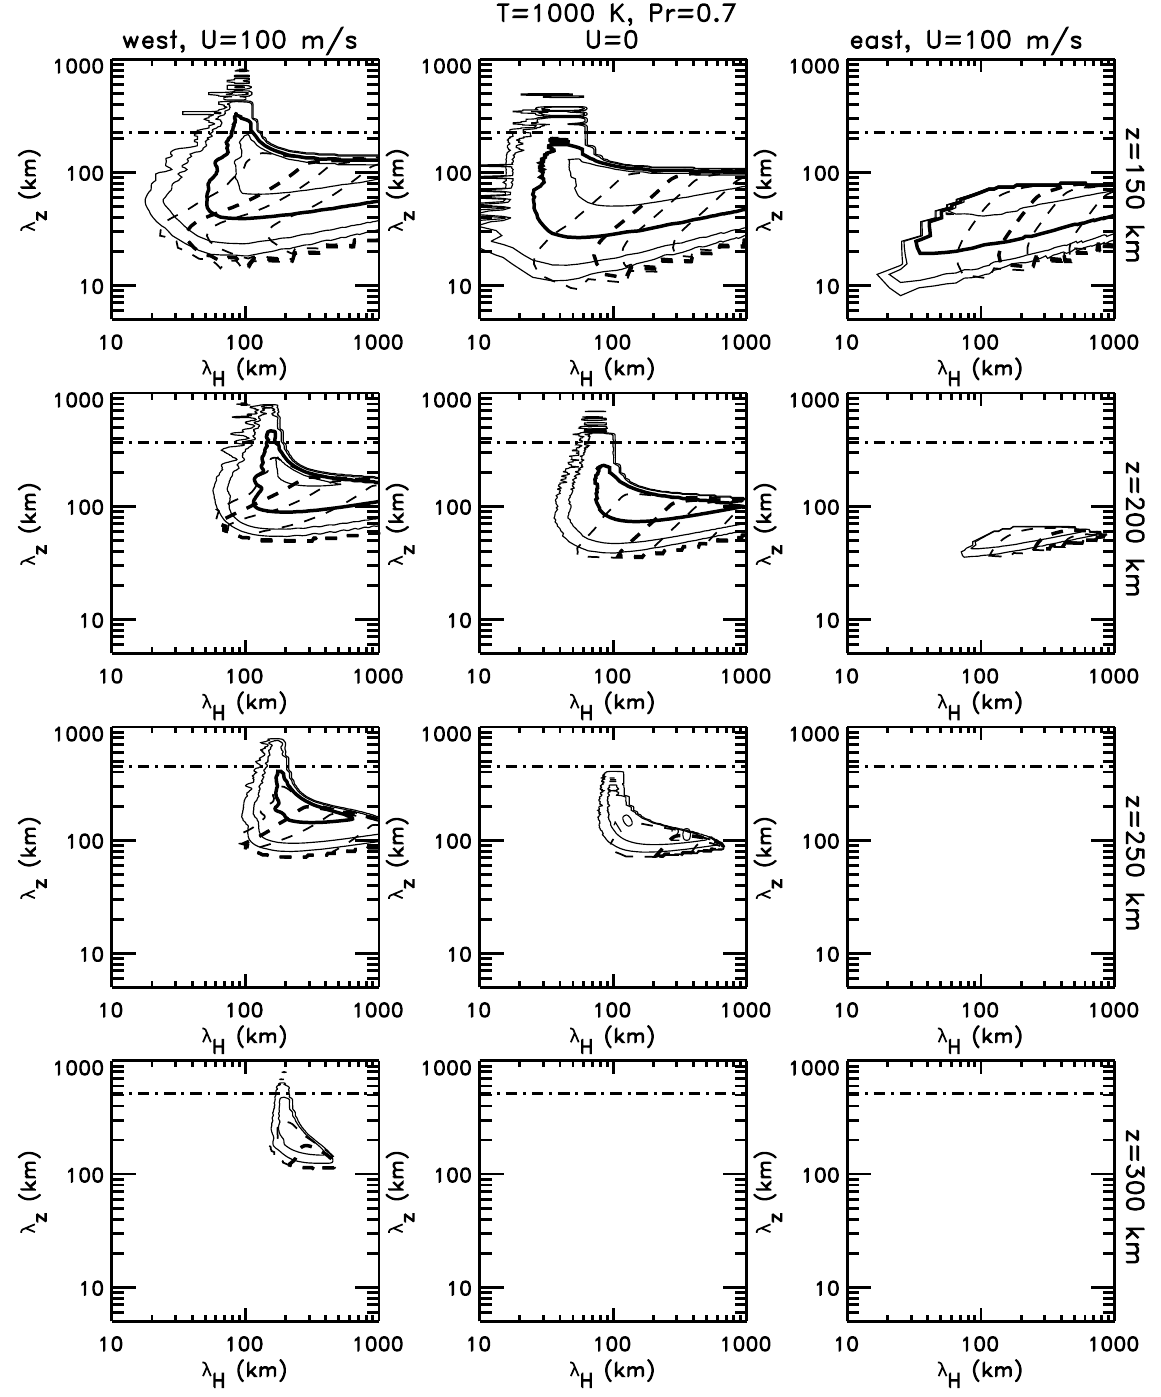
Fig. 7. As in Fig. 6, but for mean solar forcing conditions ( ∼ 1000K thermospheric temperature). Note that the vertical wavelength of 4 πH (shown with the horizontal dashed line in each panel), near which WKB theory does not apply, increases with solar